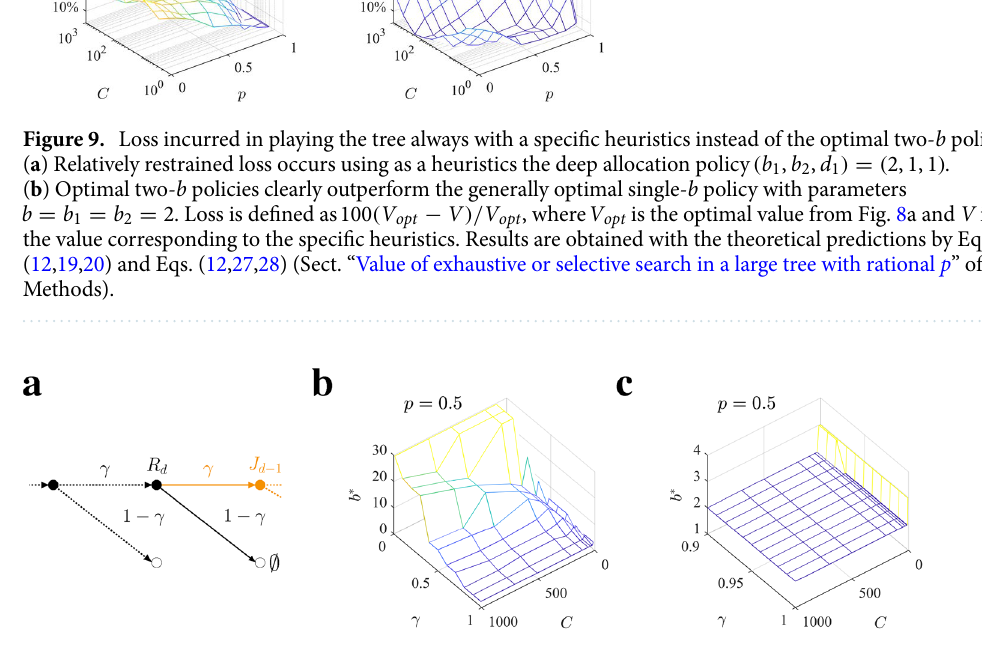
Figure 10. Depth dominates in a discounted setting in deep enough trees. ( a ) Scheme of the discounted algorithm. At level d , the agent gains the immediate reward R d and only with probability γ they are able to collect the accumulated reward J d − 1 in the future path (orange). On the contrary, with probability 1 − γ they end up in the null absorbing state with zero contribution (black, solid arrow). See Sect. “Discounted setting” of the Methods for the details and the description of the analytical solution. ( b,c ) Optimal branching factor b ∗ in the discounted setting for selective homogeneous allocation policies as a function of the temporal discount factor γ and the available resources C in an environment with p = 0.5 . The temporal discount strongly affects the optimal policy, reducing the agent horizon to a single or two levels and accordingly favoring wide allocations (b). Nevertheless, deep allocations continue to be optimal for the most relevant range 0.9 ≤ γ ≤ 1 (c), where future levels of the tree can be sampled. Results are obtained with the theoretical predictions by Eqs. (5,13,14) in Sect. “Discounted setting”and Eqs. (14,21,22) and Eqs. (14,29,30) in Sect. “Value of exhaustive or selective search in a large tree with rational p ” of the